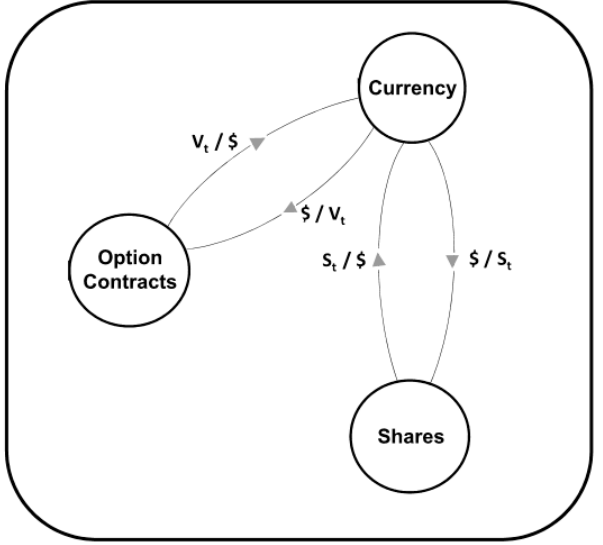
Figure 2. BSM market network connections between assets and implicit exchange rates. $: 1 USD.